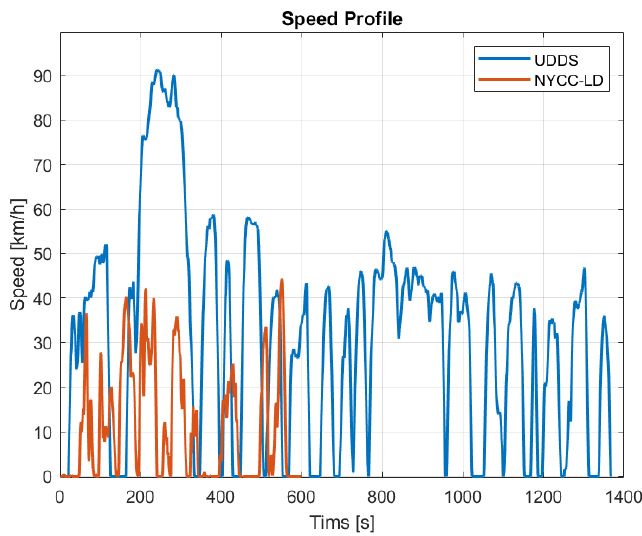
Figure 8. Speed profiles of UDDS and